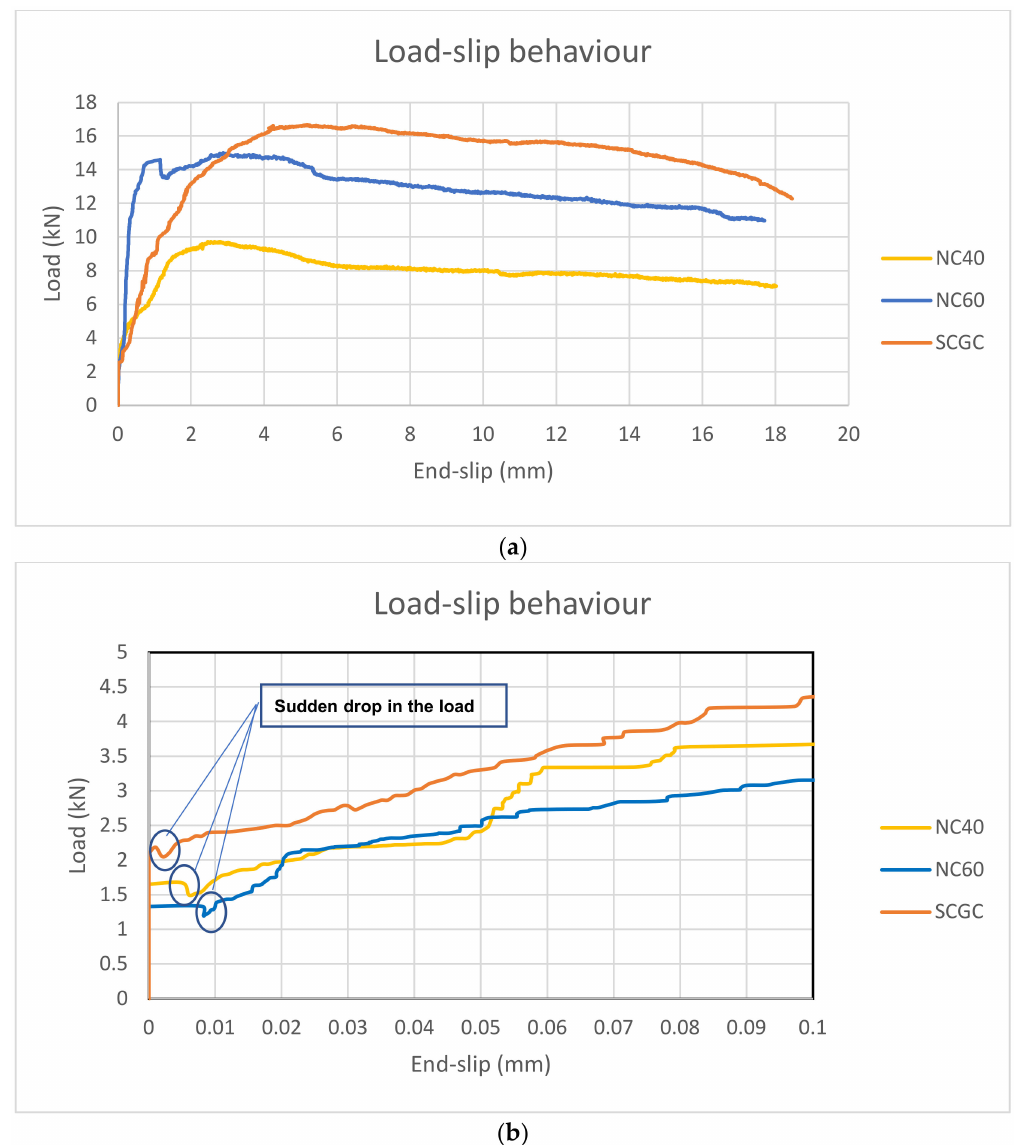
Figure 15. Average load–end slip relationships of the push test specimens. ( a ) Overall behaviour. ( b ) Enlarged